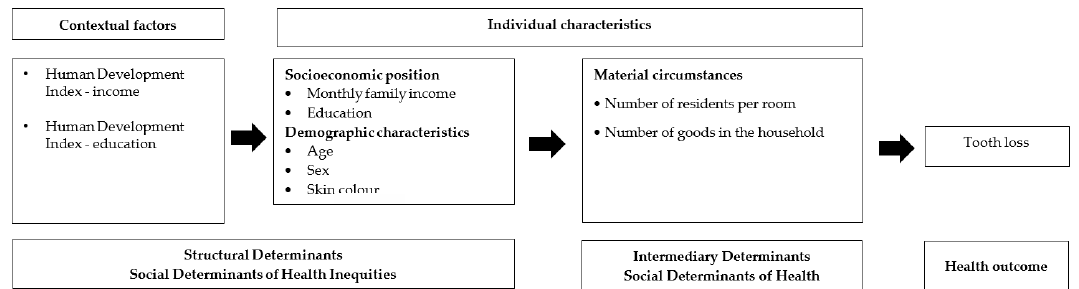
Figure 1. Theoretical model for the study of contextual and individual structural social determinants of tooth loss in elderly